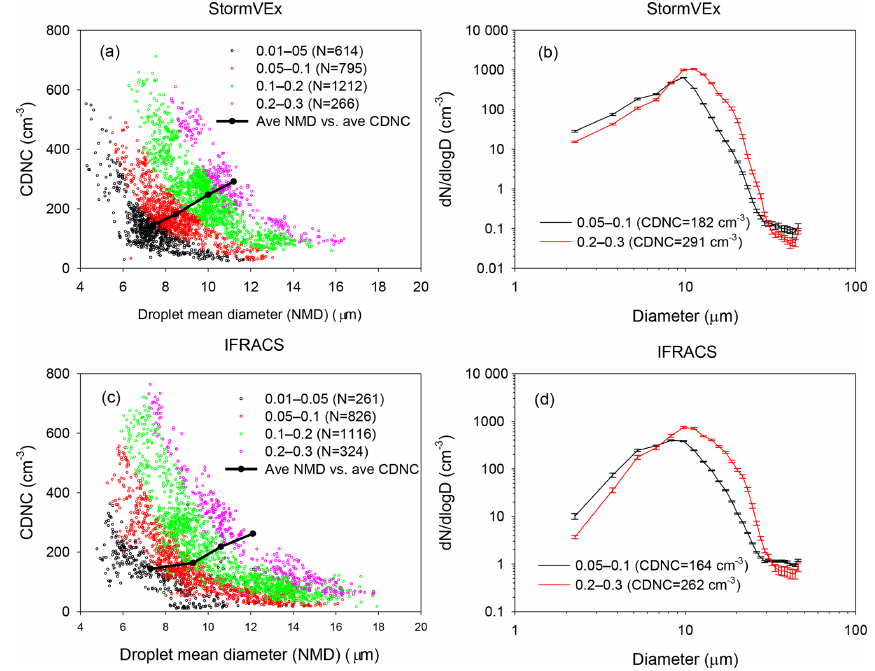
Figure 4. Relationships among 1min average mean cloud droplet diameter (NMD) and concentration (CDNC), segregated by liquid water content (LWC, gm − 3 ), as shown by colors in the legend, during StormVEx (a) and IFRACS (c) . Corresponding average PSDs for low (0.01–0.05gm − 3 ) and high (0.2–0.3gm − 3 ) LWC are shown in panels (b) and (d) . The error bars in panels (b) and (d) are standard